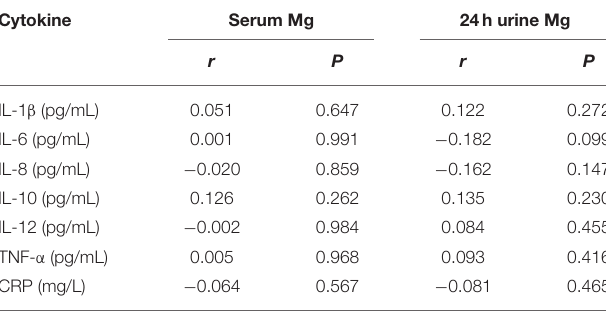
TABLE 8 | Correlation coefficients between Mg and serum pro-inflammatory cytokines in DN patients.